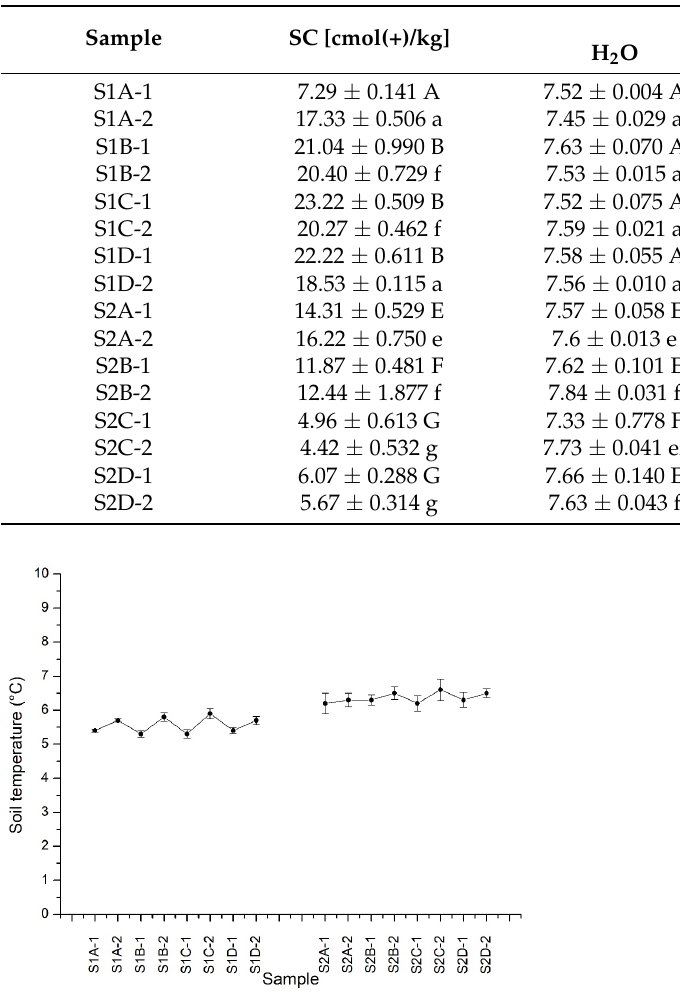
Figure 2. The soil temperature in the studied areas during sampling, and in situ analysis. S1: soil from the limestone open-cast mining remediated with embankment; S2: soil from the lignite open-cast mining remediated with sewage sludge; subsequent letters A–D mean different remediated areas located at the same mine; subsequent numbers mean different sampling periods; 1:spring 2021, 2:spring 2022. Mean values ± SD, n = 3.